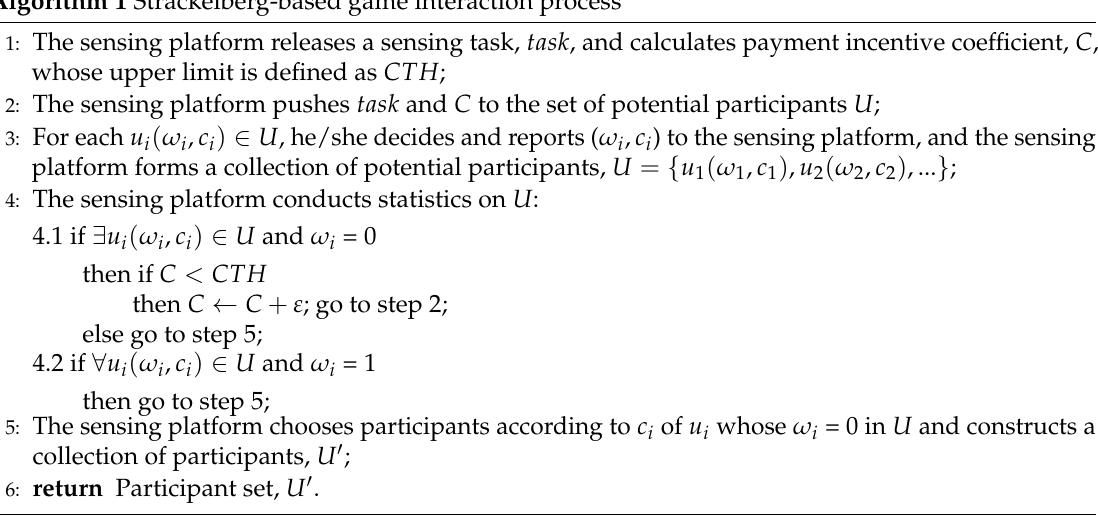
Algorithm 1 Strackelberg-based game interaction